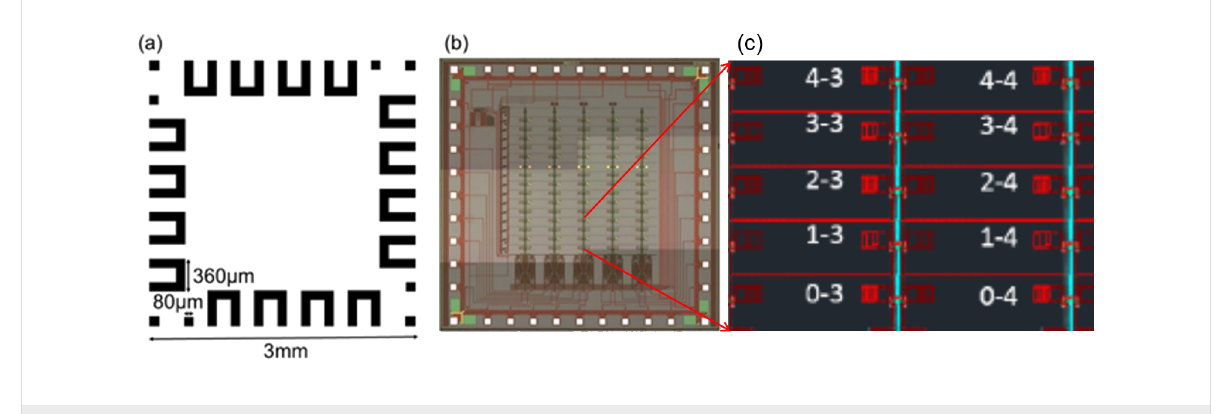
Figure 1: (a) Layout of the dummy chip mimicking the size of the sensor chip and the contact pad positions and sizes. (b) Microscope image of the capacitance sensor chip showing contact pads at the periphery and an array of sensors distributed over 16 rows and 5 columns. (c) Close up of capacitive finger electrode